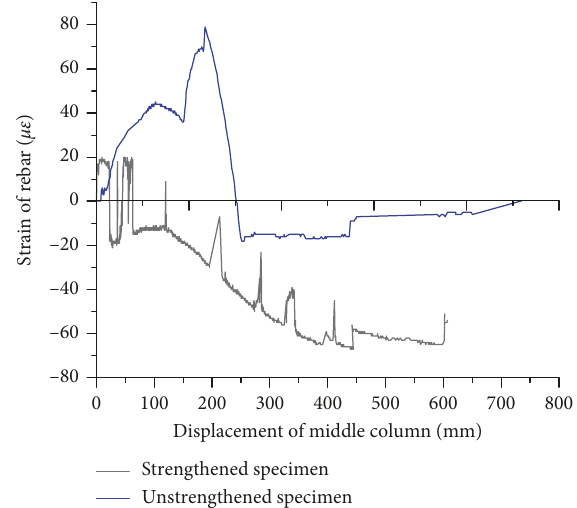
Figure 12: Strain on the square steel tube